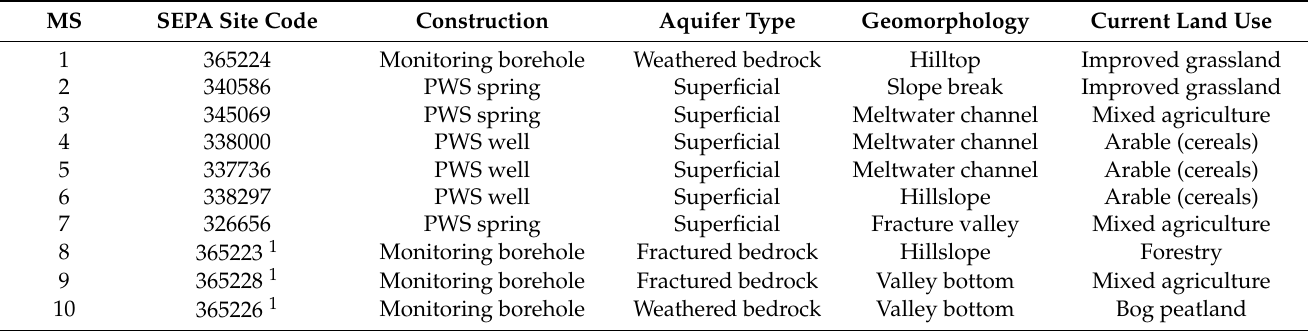
Table 1. Summary of the SEPA Ythan groundwater Monitoring Stations